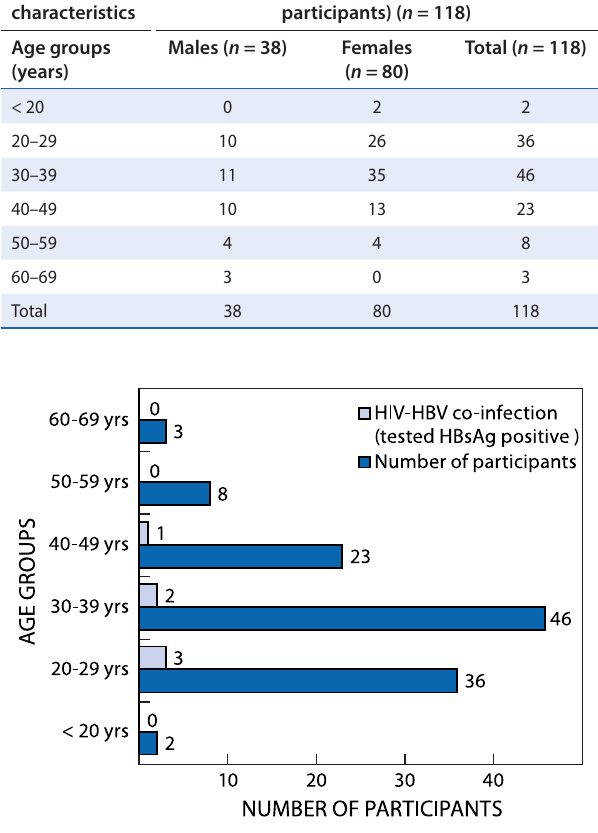
Table 1: Baseline characteristics of HAART-eligible adult patients in the Mahalapye, Ngami and Serowe Health Districts, August to October 2015 Patient characteristics